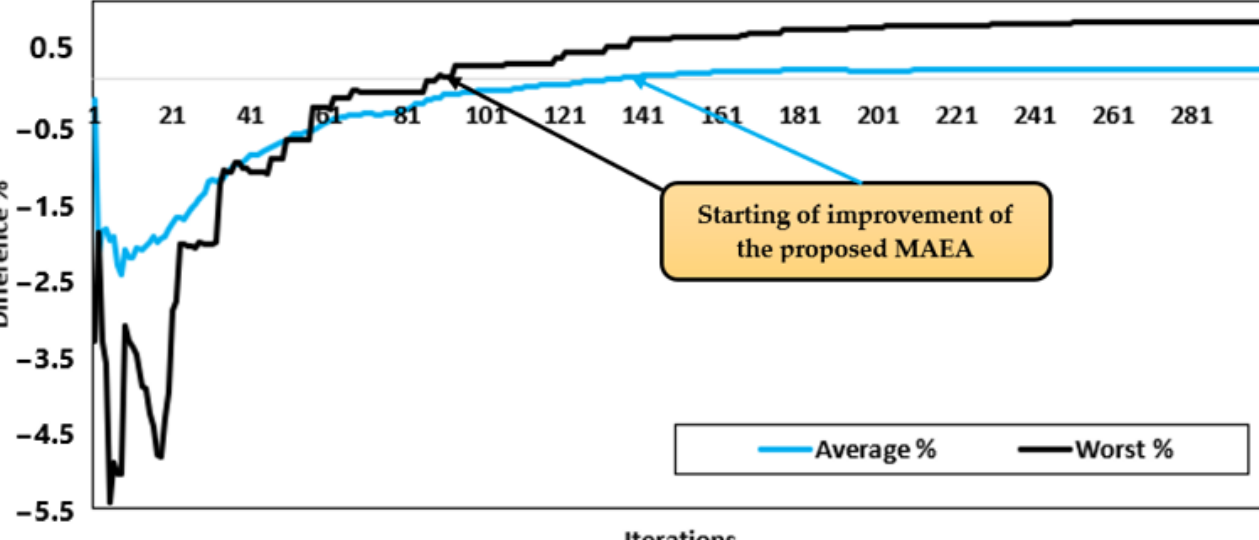
Figure 9. Percentage difference for the worst run and the average of all runs of the MAEA and AEA of Case 2.